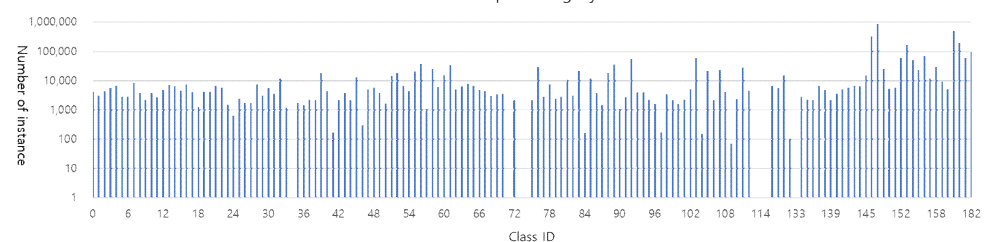
Figure 11. Number of instances in each class (151 classes).